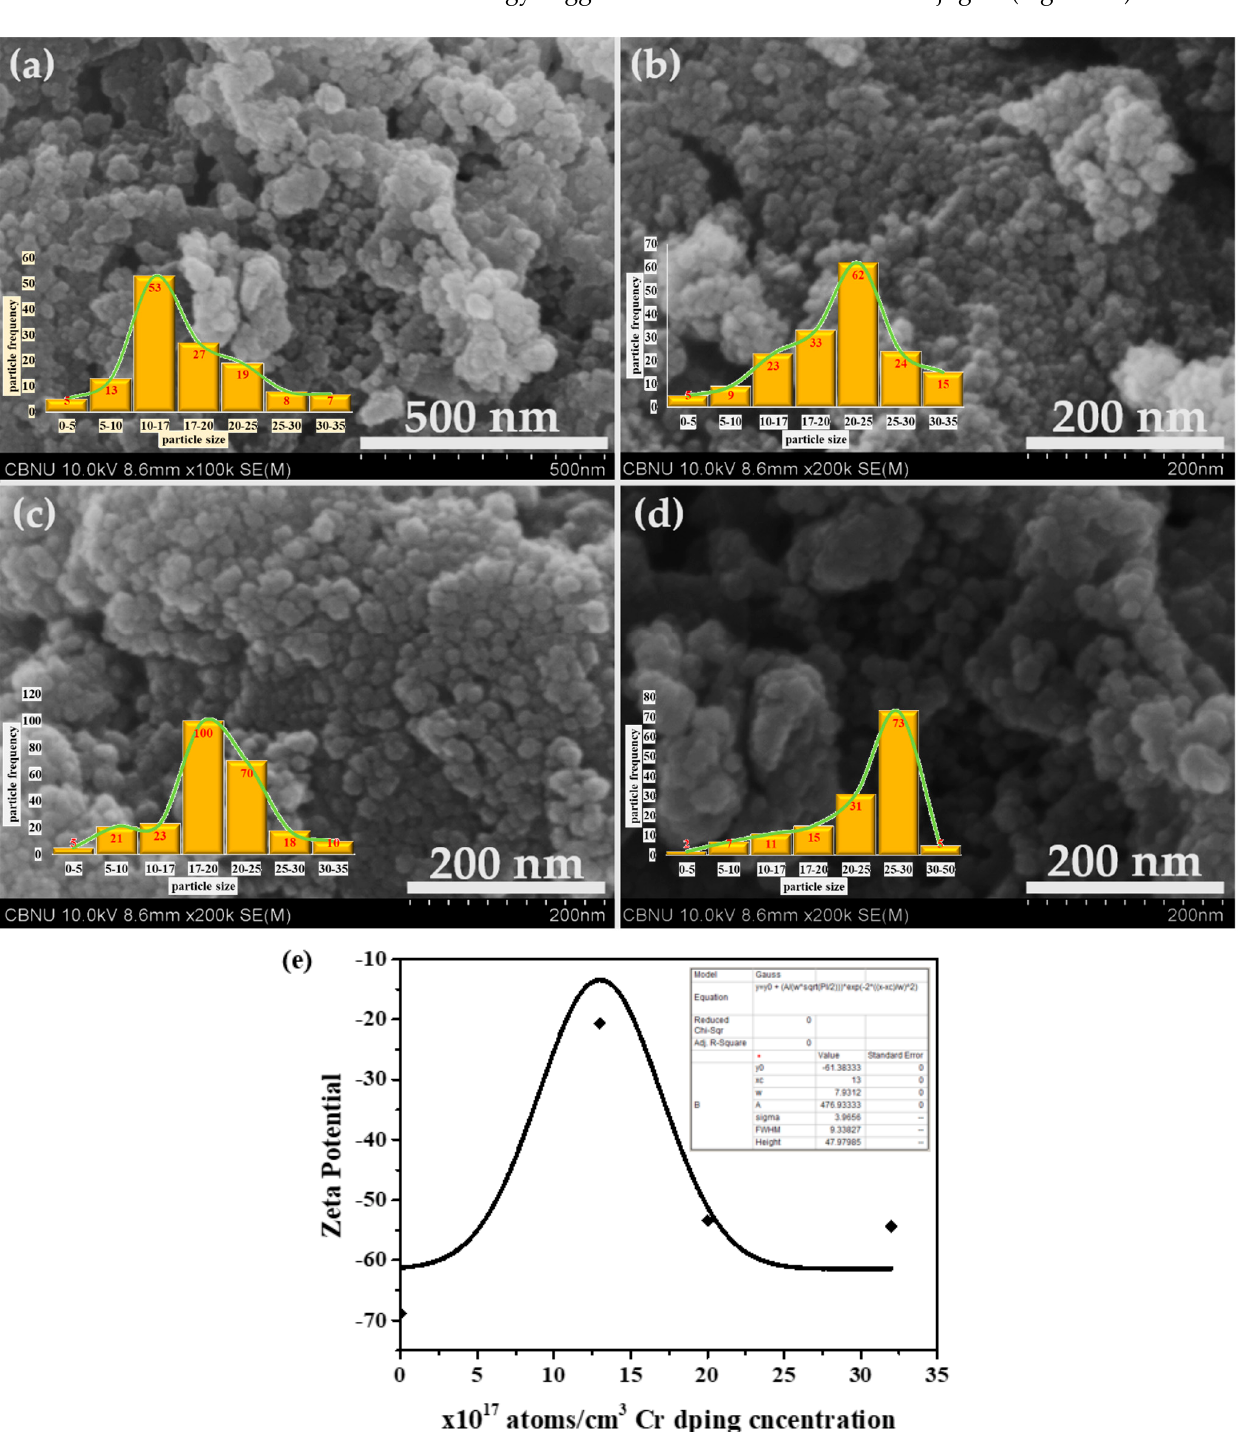
Figure 1. Typical FESEM images of synthesized pure ZnO and Cr-doped ZnO NPs. ( a ) Pure ZnO; ( b ) ZnO-Cr (Cr = 13 × 10 17 atoms/cm 3 ); ( c ) ZnO-Cr (Cr = 20 × 10 17 atoms/cm 3 ); and ( d ) ZnO-Cr (Cr = 32 × 10 17 atoms/cm 3 ). ( e ) Zeta potential graph for all synthesized nanoparticles.